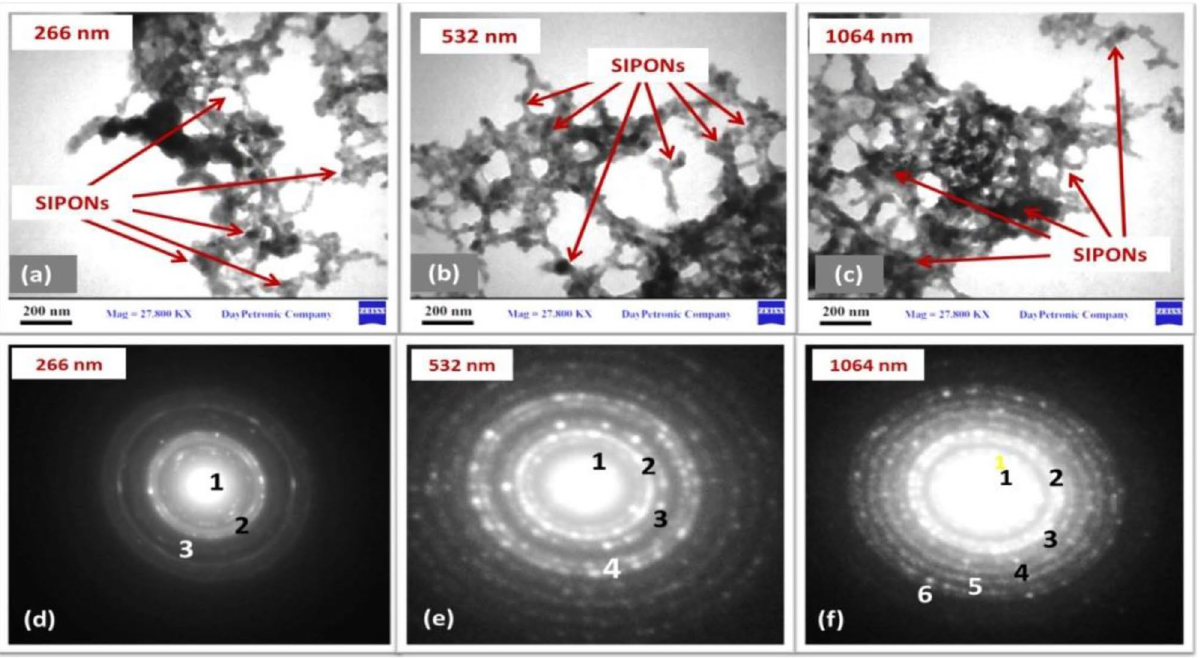
Figure 9. TEM images showing of Fe 3 O 4 NP concentrations at different wavelengths: ( a – c ) 266, 532, and 1064 nm in KMnO 4 solution. ED patterns of Fe 3 O 4 NP ( d – f